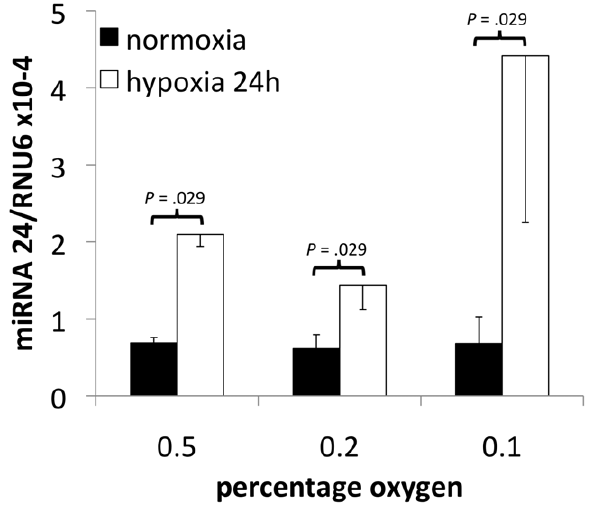
Figure 4. miRNA-24 expression after hypoxia. Expression levels (average + / 2 SD, n=4) measured by RT-qPCR of miRNA-24 controlled for RNU6 expression in MDA-MB-231 cells exposed to 0.5%, 0.2% or 0.1% oxygen during 24